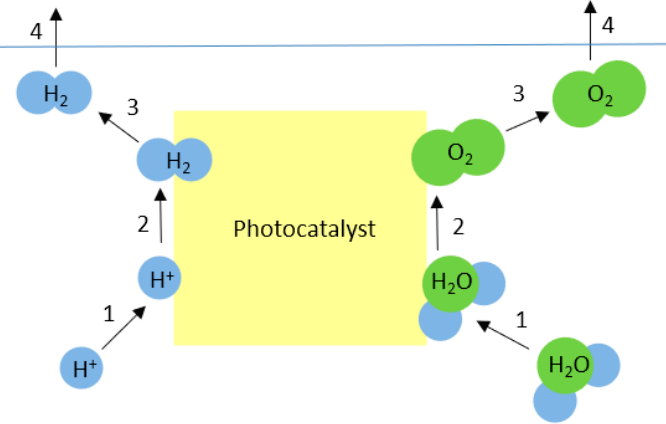
Figure 3. Schematic representation of mass transfer steps in photocatalytic water splitting. (1) Ad- sorption of the reactants, (2) reduction/oxidation of the reactants, (3) desorption of the products, and (4) transfer of the products from the photocatalyst surface to the gas phase.